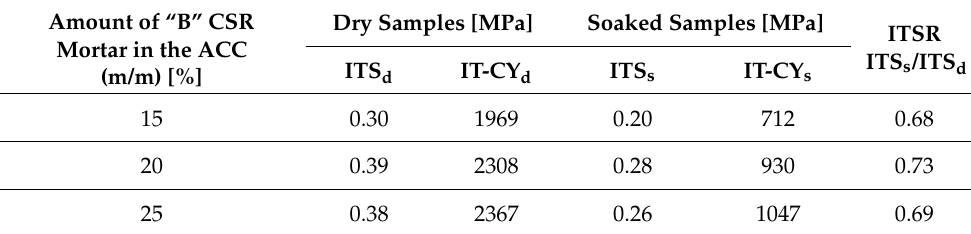
Table 3. ITSR water resistance of ACCR with B mortar samples Ø100 mm × 63.5 mm, tested at the temperature of 5 ◦ C, after 28 days of curing.